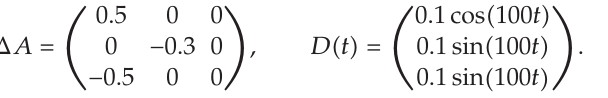
Figure 1: State trajectories of drive system (cid:7) 4.2 (cid:10) and response system (cid:7) 4.3 (cid:10) , (cid:7) a (cid:10) signals x 1 and x 2 ; (cid:7) b (cid:10) signals y (cid:7) c (cid:10) signals z z (cid:7) d (cid:10) the error signals e y 1 and 2 ; 1 and 2 ; di ff erent initial conditions under the controller (cid:7) 4.7 (cid:10)